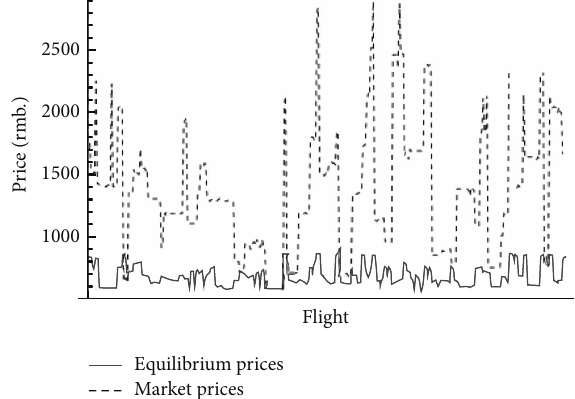
Figure 4: Equilibrium prices (Chinese market).